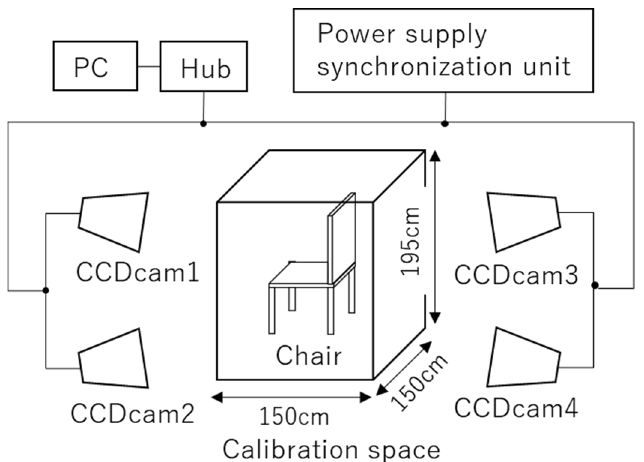
Figure 2. Experimental setup. A calibration space (150 cm × 150 cm × 195 cm) photographed with four CCD cameras.